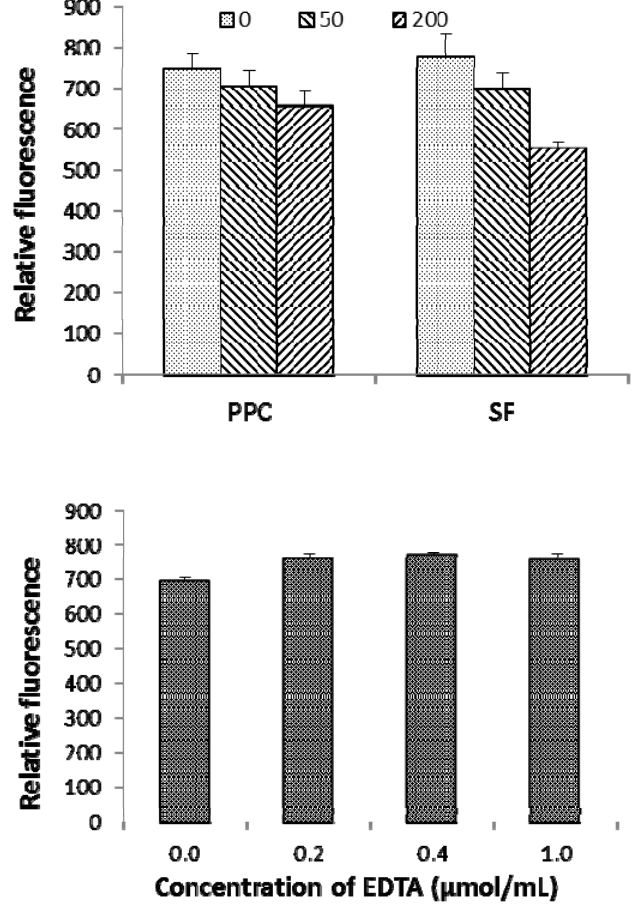
Figure 3. Quenching of 1- N -phenylnaphthylamine (NPN) fluorescence by addition of condensed tannins (0, 50 and 200 µg/mL; a ) from purple prairie clover (PPC; Dalea purpurea Vent.) and sainfoin (SF; Onobrychis viciifolia ), in comparison with addition of ethylenediaminetetraacetic acid (EDTA; b ), to Escherichia coli (ATCC 25922) suspension prepared from non-exposed bacteria. Bars indicate standard